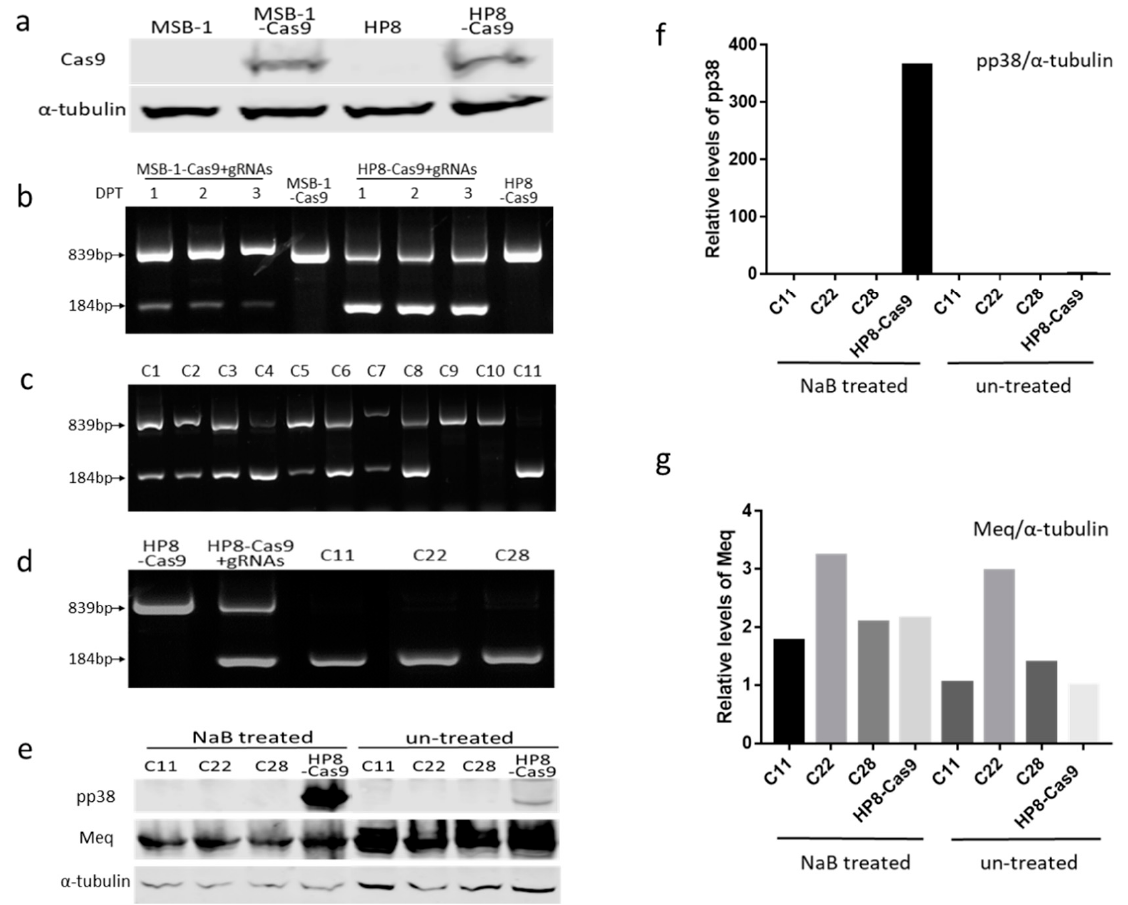
Figure 2. Deletion of the pp38 gene by CRISPR / Cas9 editing in HP8 cells. ( a ) Detection of Cas9 expression on single clones of MSB-1 and HP8 cell lines stably expressing Cas9 by western blotting. Cell lysates of MSB-1-Cas9 and HP8-Cas9 along with MSB-1 and HP8 were separated by SDS-PAGE, Western blotted, and probed with anti-Flag antibody, α -tubulin was used as the loading control. ( b ) PCR amplification of the edited region, using primers NF and CR on the cell lysates of transfected cells at 1, 2, and 3 days post transfection. DPT, days post transfection ( c ) PCR amplification of the pp38 locus on isolated single cell clones of transfected HP8-Cas9 with two part gRNA system showing the two bands. ( d ) PCR results of selected clones used for subsequent analysis. The unedited HP8-Cas9 and the mixed population after editing (HP8-Cas9 + gRNAs) were also included. ( e ) Detection of pp38 expression by western blotting with anti-pp38 monoclonal antibody BD1 and anti-Meq monoclonal antibody FD7 before and after NaB treatment on HP8-Cas9 and the edited clones. For the loading control, the same blot was stripped and re-probed with anti- α -tubulin antibody. ( f ) and ( g ) Relative signal intensities of the pp38 ( f ) and Meq ( g ) western blot band were quantified using ImageQuant and normalized against the corresponding signal from the α -tubulin band. The signal from untreated control HP8-Cas9 cells was set as 1.